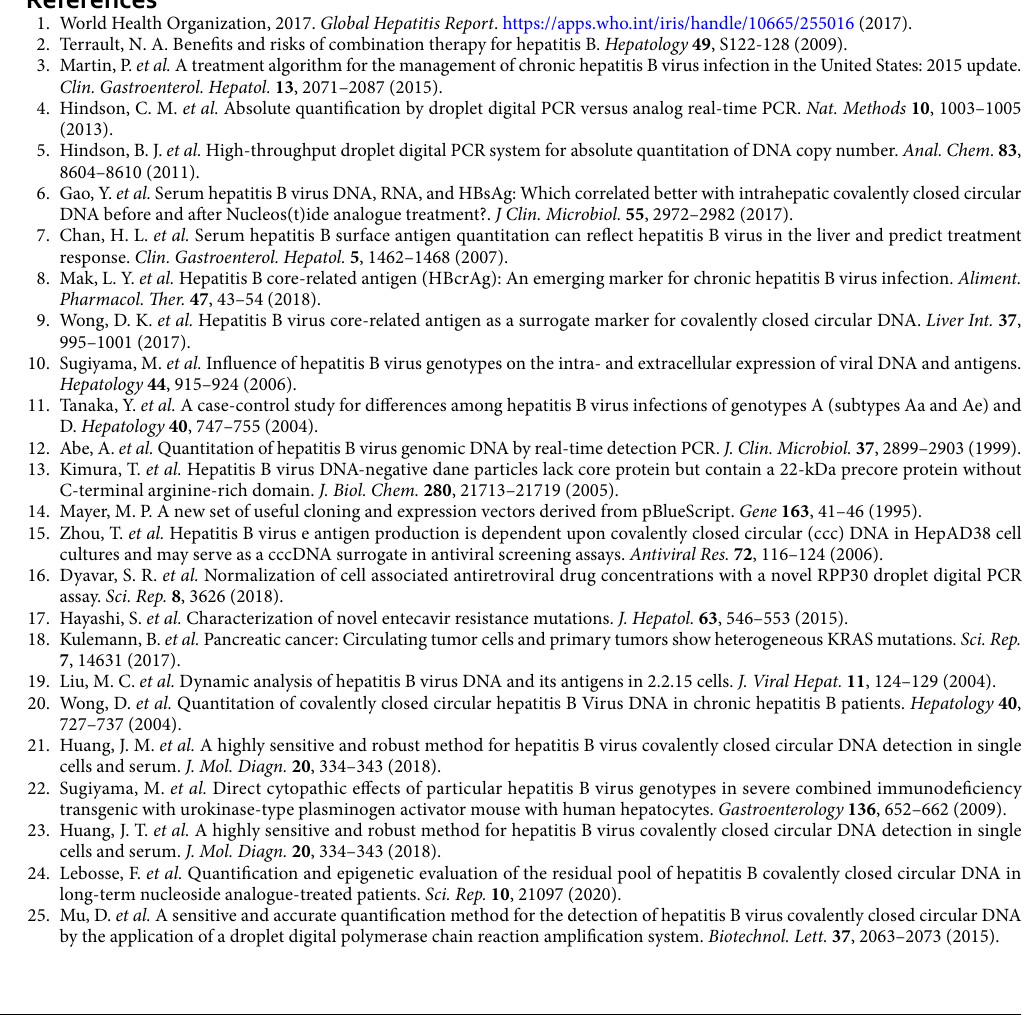
Figure 5. Changes of intrahepatic cccDNA content and serum ALT in CHB patients with HBV infection by PEG-IFN treatment. Effect of PEG-IFN treatment on intrahepatic cccDNA/10 4 cells and serum ALT in CHB patients with ( A ) non-VR, ( B ) VR without HBsAg clearance and ( C ) VR with HBsAg clearance, during and after PEG-IFN treatment. These patients were treated with PEG-IFN monotherapy (180 µg/week) for 48 weeks and then followed for another 48 weeks after PEG-IFN withdrawal. ( D ) Each dot represents the average of duplicate tests for the copy number of intrahepatic cccDNA level in 100 ng total DNA of each patient. The Mann–Whitney U-test was used to examine statistical difference between the two groups. The mean values of the two groups were depicted by red dots, and were 217.7 (30.7–674.0) in the non-VR group and 39.8 (0.4–256.8) in the VR group. ( E ) Each dot represents the average of duplicate tests for the copy number of cccDNA per hepatocyte of each patient. The Mann–Whitney U-test was used to examine the statistical difference between the two groups. The mean values of the two groups were depicted by red dots, and were 0.088 (0.013–0.293) in the non-VR and 0.0206 (0.0002–0.0659) in the VR groups. ( F ) The reduction of cccDNA/ cell (%) from baseline to the end of treatment was calculated in each patient, and the statistical difference was determined by the Mann–Whitney U-test. Red dots depict the mean values in the two group. ( G ) The peak levels of ALT during PEG-IFN treatment were 88.5 (58–111) in the non-VR and 222.0 (93–500) in the VR group. Comparison between two groups was performed by the Mann–Whitney U test. ( H ) Negative correlation between intrahepatic cccDNA at week 48 and the peak levels of ALT in CHB patients. The correlation between variables was analyzed using Spearman’s rank correlation